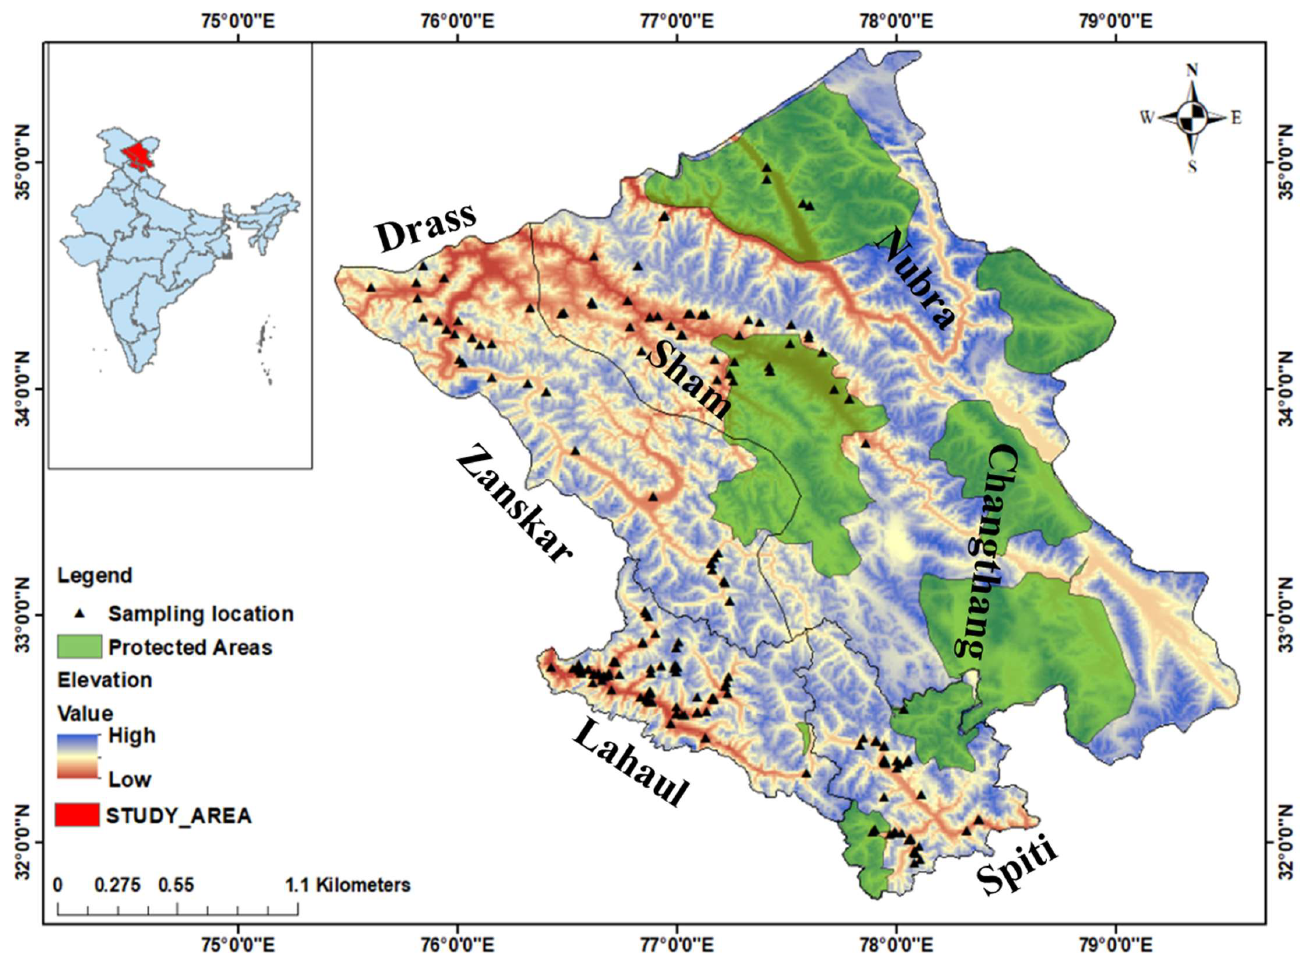
Figure 1. Geographic map of study area showing protected areas and sampling location of Himalayan ibex in distribution range of India. (LA—Nubra, Sham, Drass and Zanskar; LS—Lahau, Spiti).